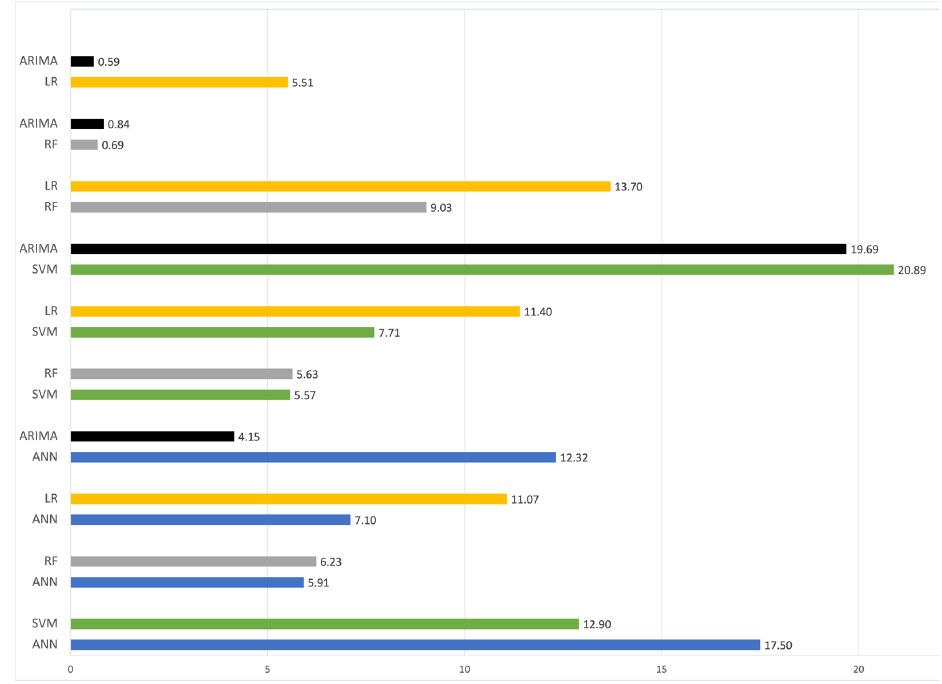
Figure 3. Pair-wise comparison using average performance.